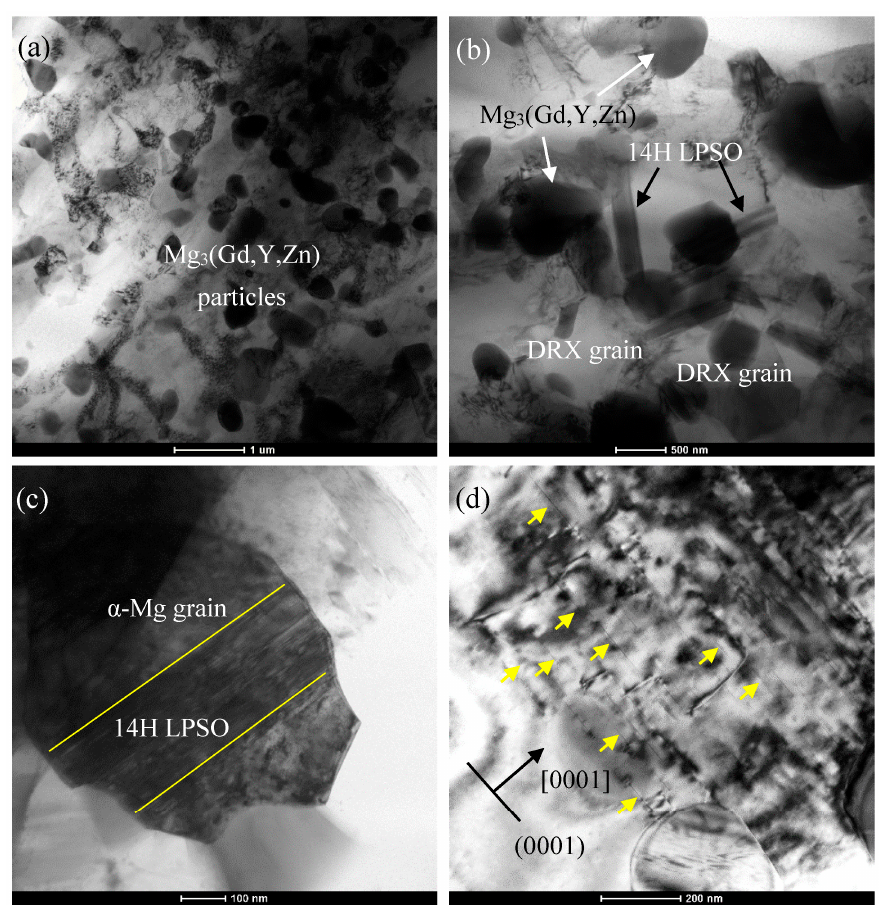
Figure 8. TEM images of ECAP alloys: ( a ) Refined Mg 3 (Gd,Y,Zn) particles; ( b ) mixed area in Figure 7c; ( c ) an α -Mg grain with a 14H cluster inside (the 14H phase is located within two yellow lines); ( d ) γ′ precipitates formed in 16p-ECAP alloy (some γ′ precipitates are marked by yellow arrows).